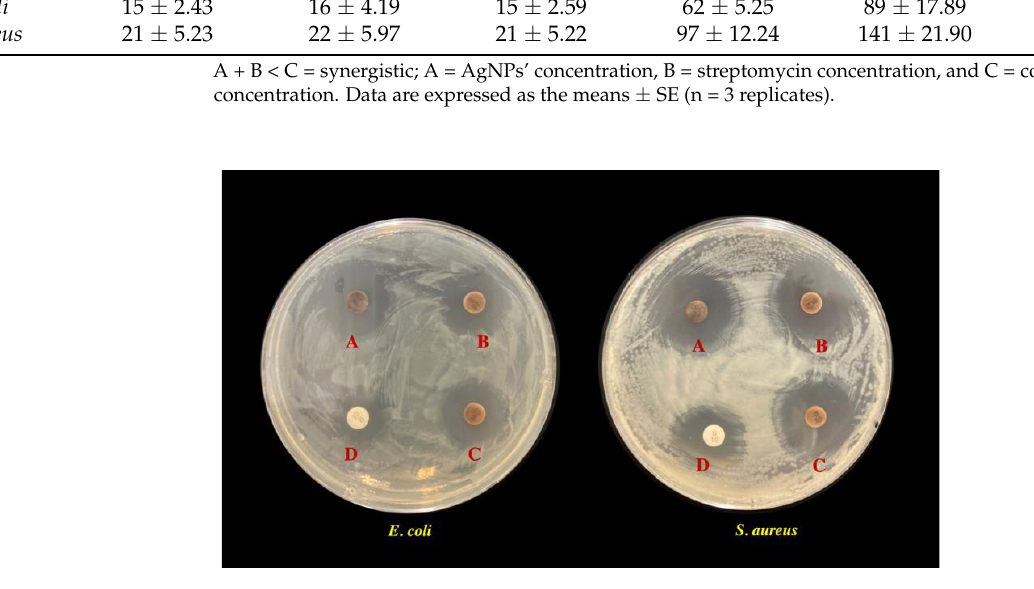
Figure 8. Effect of combination of LED-biosynthesized AgNPs and streptomycin against S. aureus and E. coli K 12 evaluated by the disk diffusion method: A is AgNPs-blue LED and streptomycin, B is AgNPs-green LED and streptomycin, C is AgNPs-infrared LED and streptomycin, and D is streptomycin alone. The diameter of the petri dish is 9 cm.